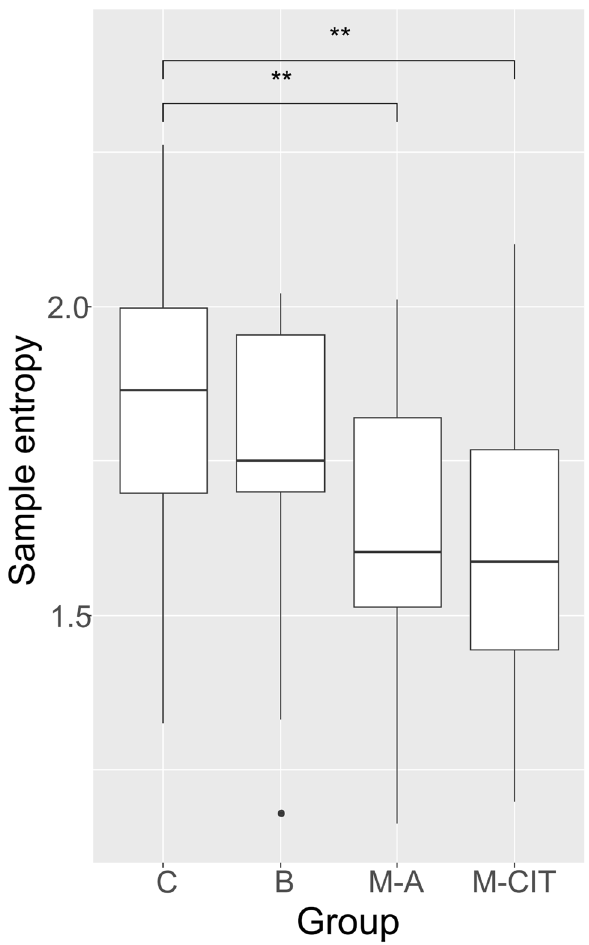
Figure 3. Intergroup comparison of the sample entropy. Brackets indicate significant differences between groups (**p < 0.01; LSD). C control group, B benign tumor, M-A survivors with active cancer, M-CIT survivors after completed initial treatment.